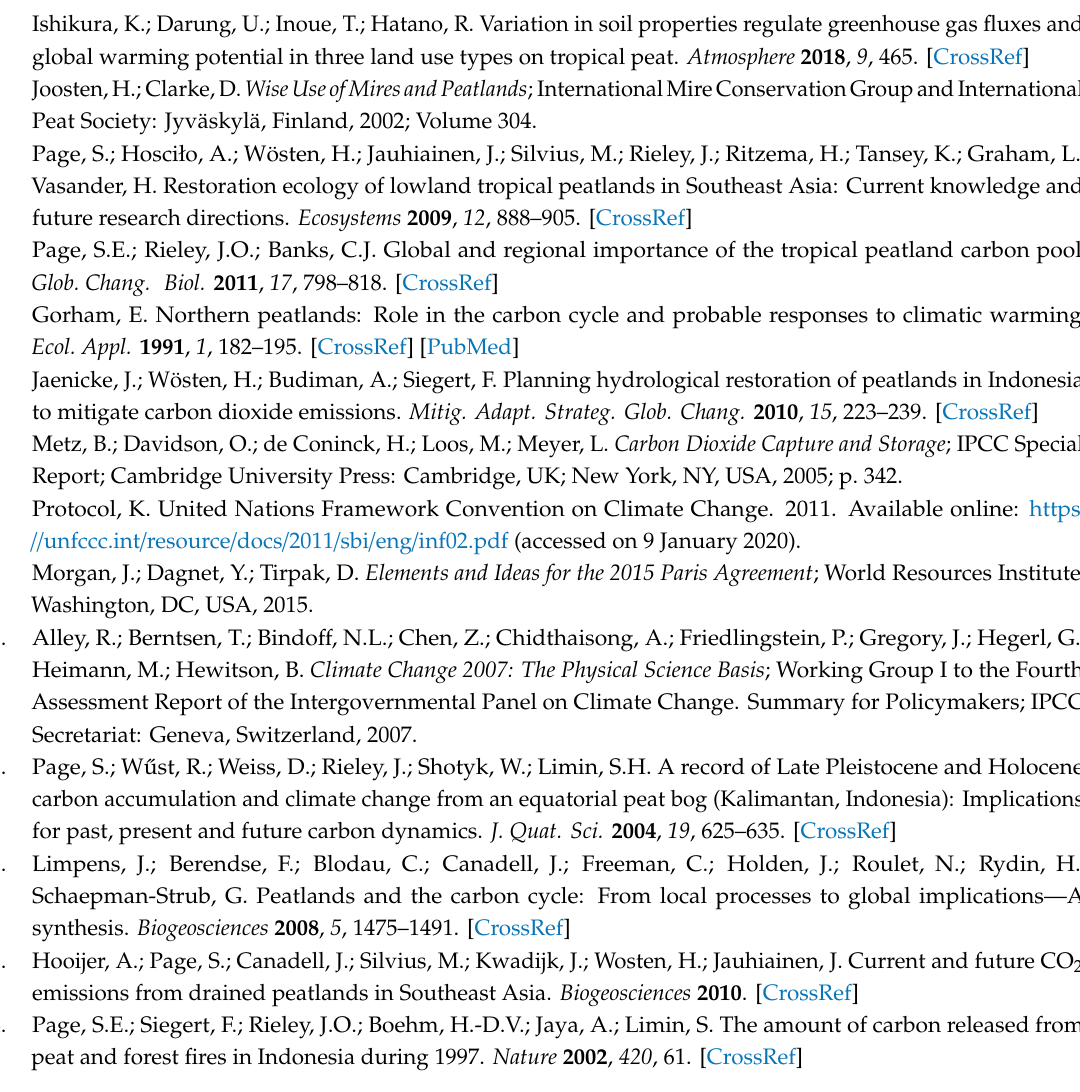
Ishikura, K.; Darung, U.; Inoue, T.; Hatano, R. Variation in soil properties regulate greenhouse gas fluxes and global warming potential in three land use types on tropical peat. Atmosphere 2018 , 9 , 465.